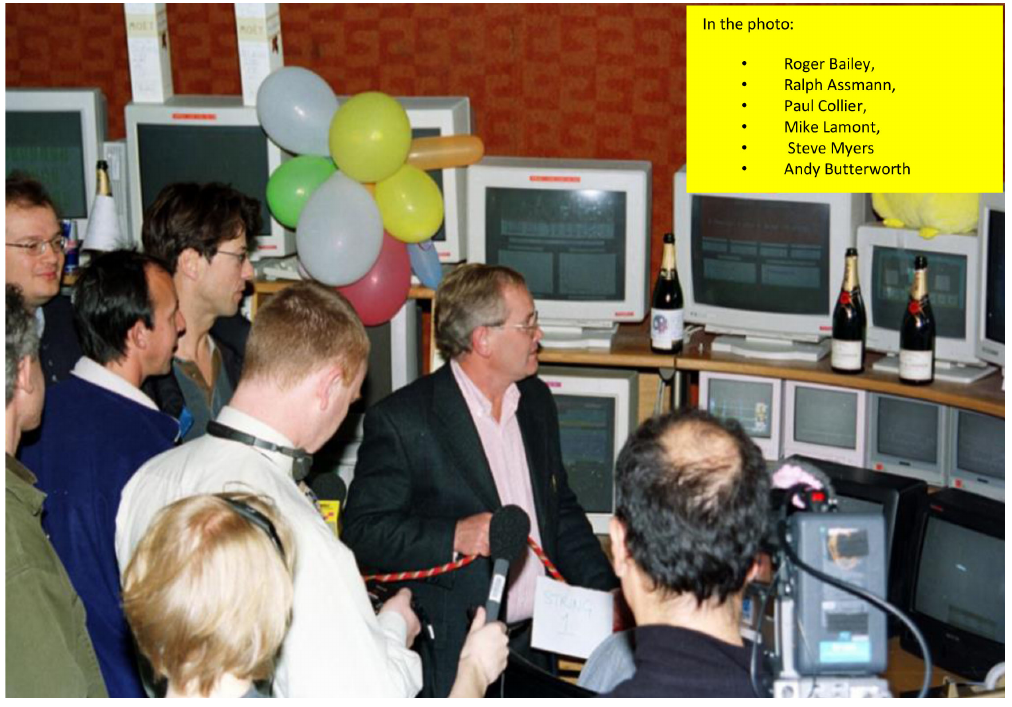
FIG. 27. Last beam dump in